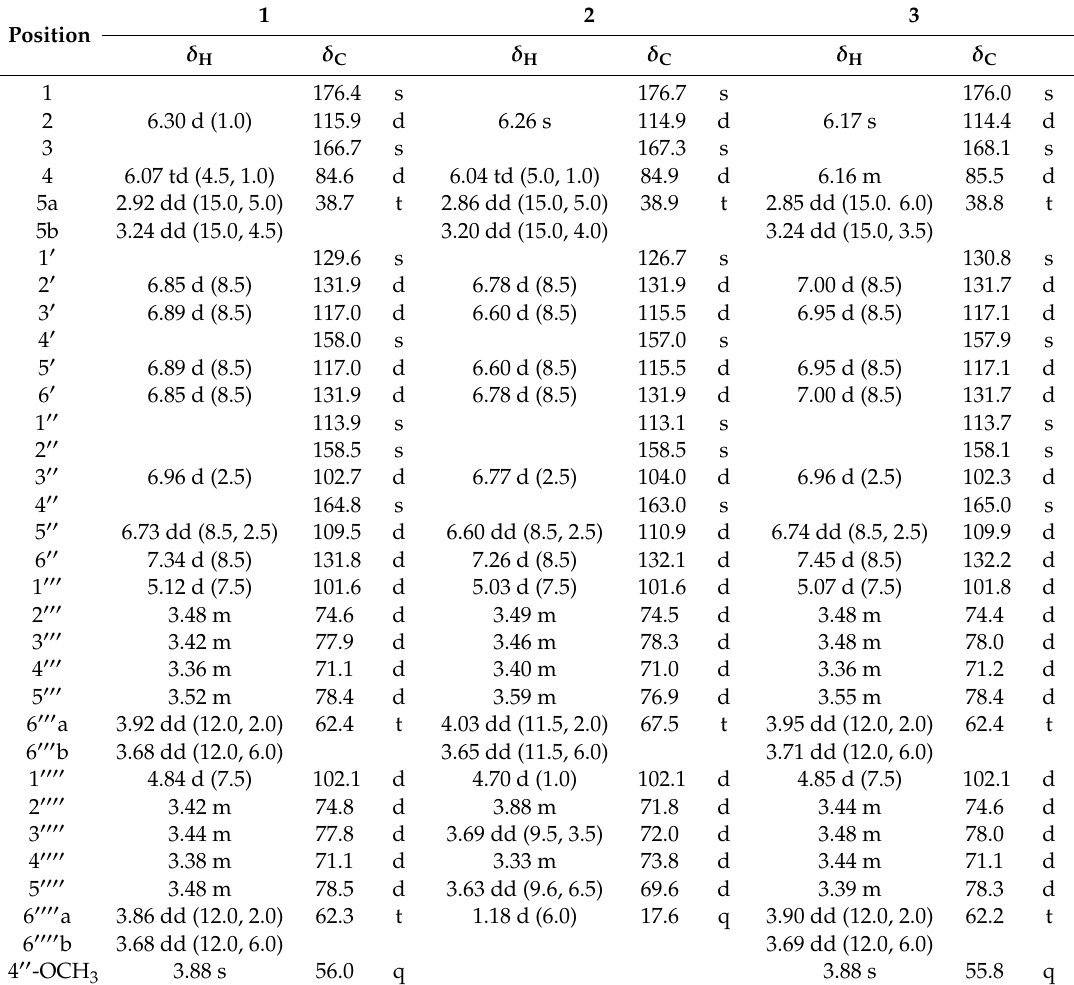
Figure 2. 1 H– 1 H correlation spectroscopy (COSY) (blue bold lines) and key heteronuclear multiple bond correlation (HMBC) (red arrows) correlations of 1 and 2 . Table 1. 1 H and 13 C nuclear magnetic resonance (NMR) data of Compounds 1 – 3 in CD 3 OD a